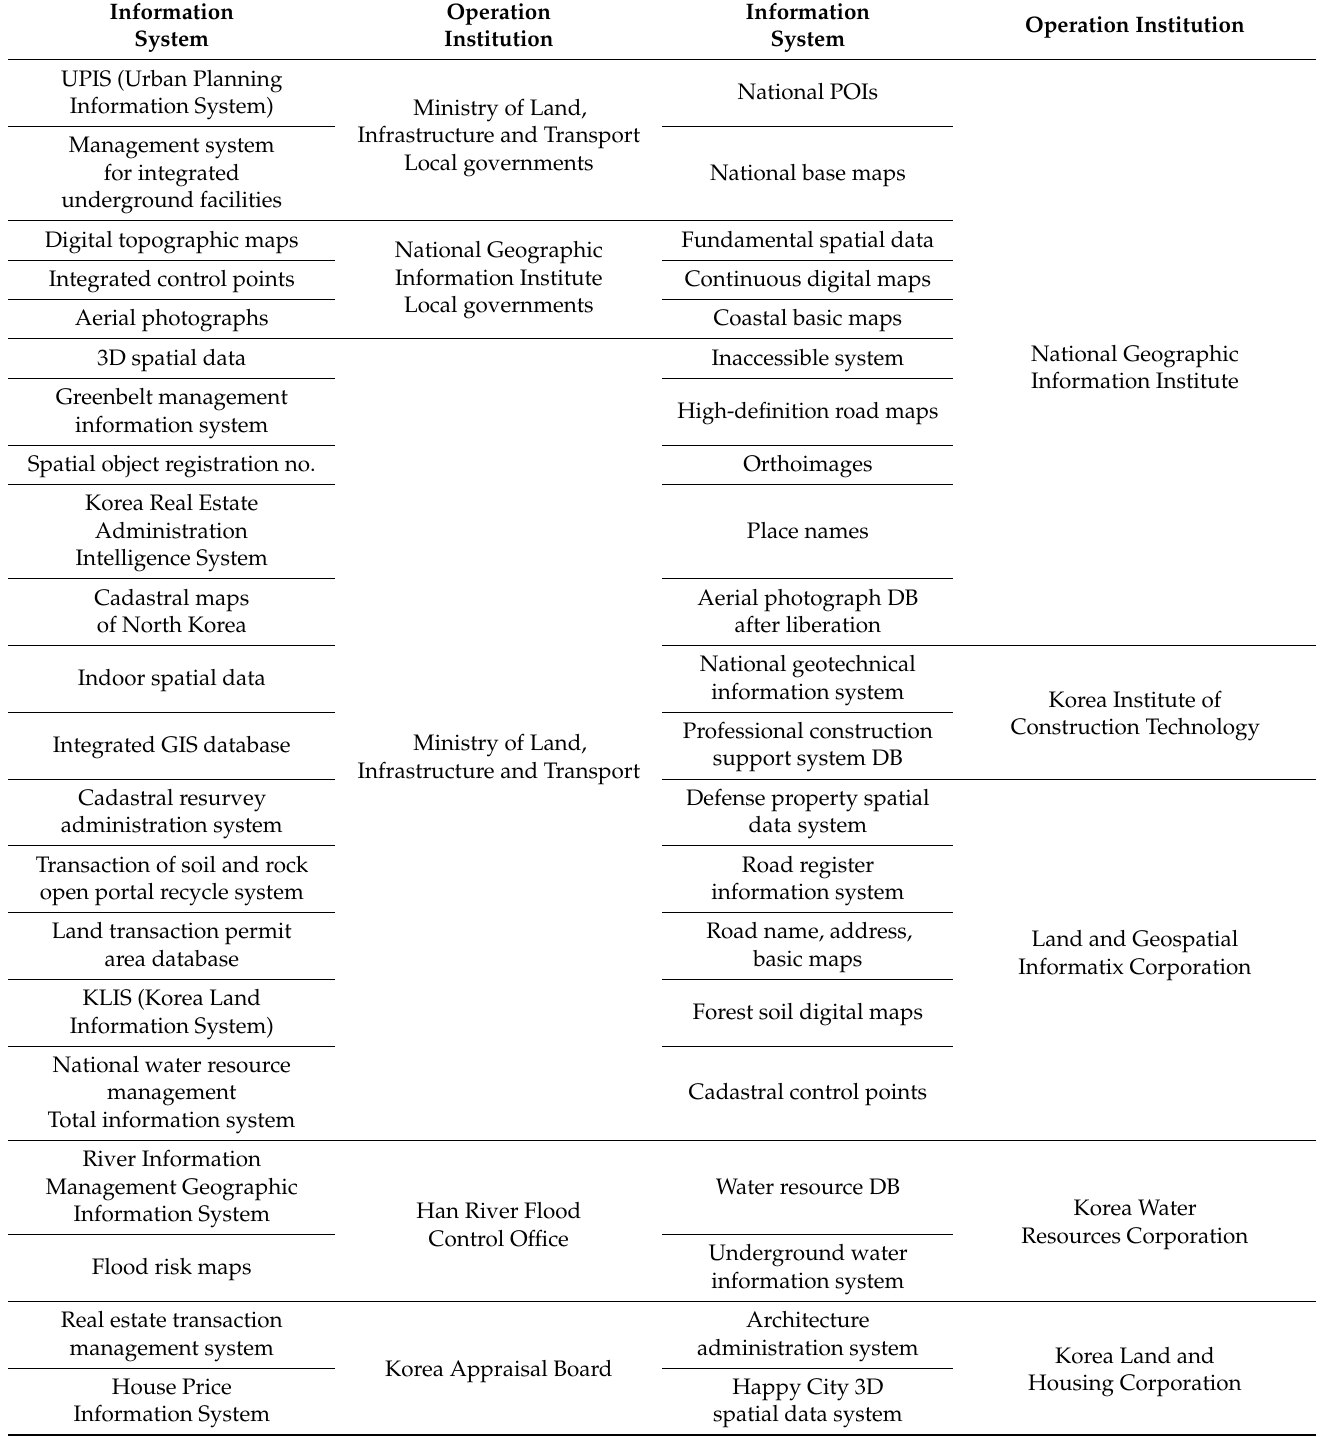
Table 5. Spatial data production